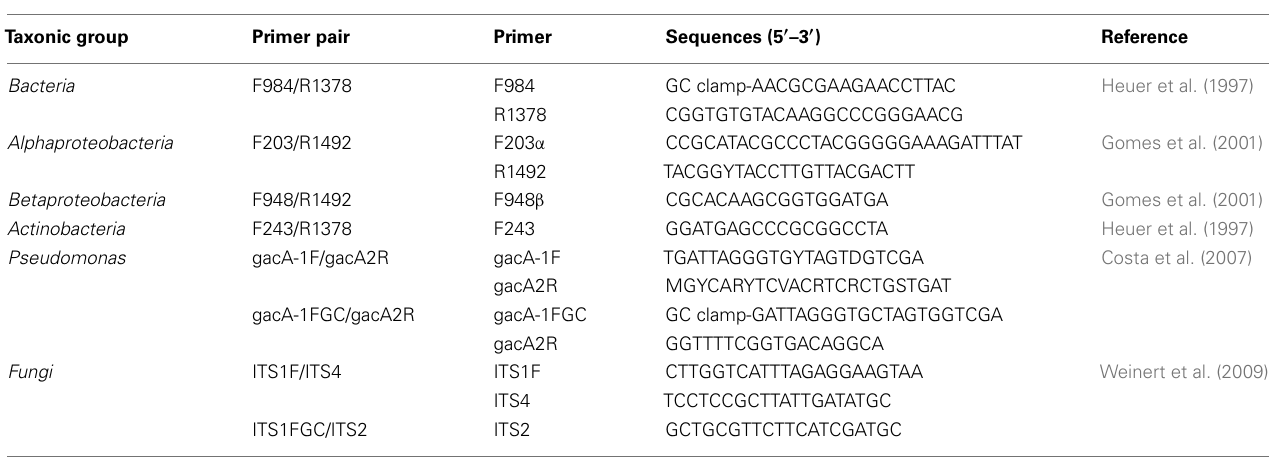
TableA1 | Primers used in this study. Taxonic group Primer pair Primer Sequences (5 (cid:48) –3 (cid:48) )